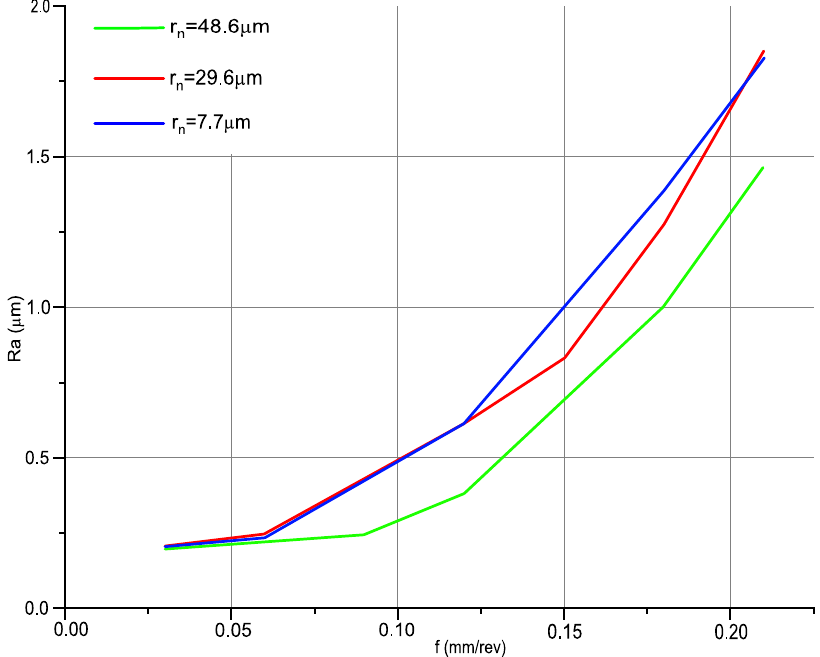
Figure 8. Effect of feed rate and edge radius on the surface roughness parameter Ra : v c = 360 m/min; f = 0.03–0.21 mm/rev; a p = 0.35 mm.